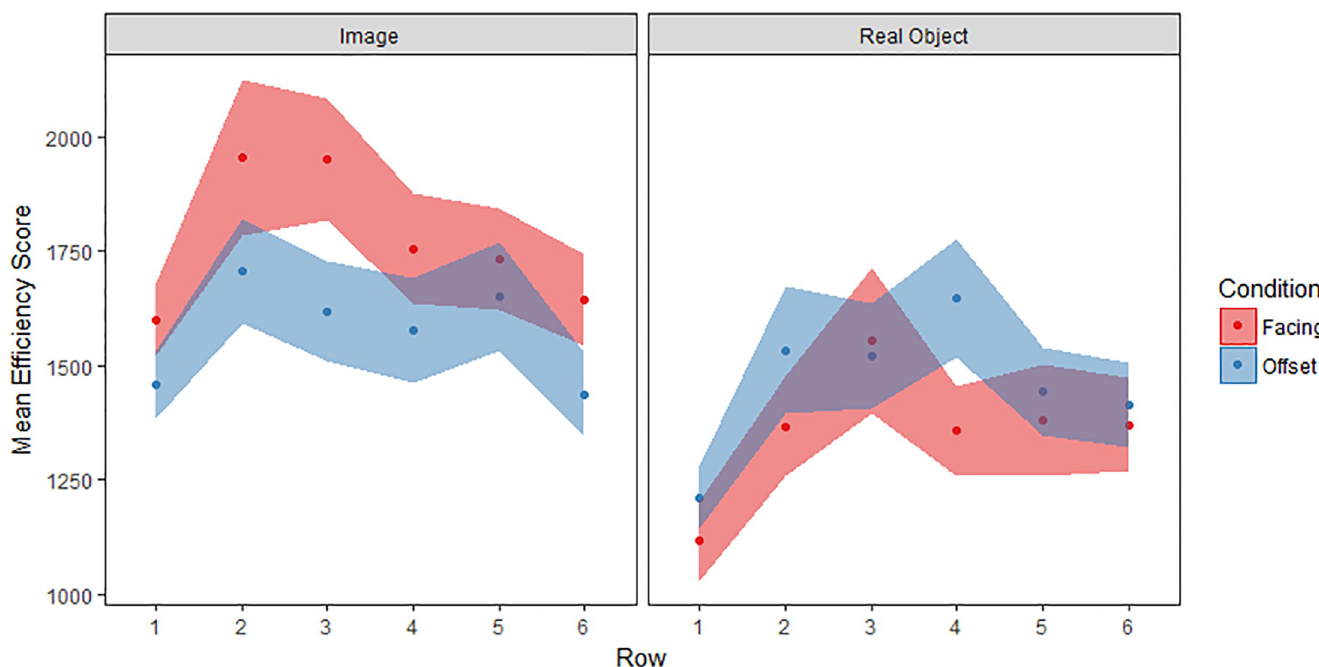
Fig 5. Efficiency scores (M ± SE).